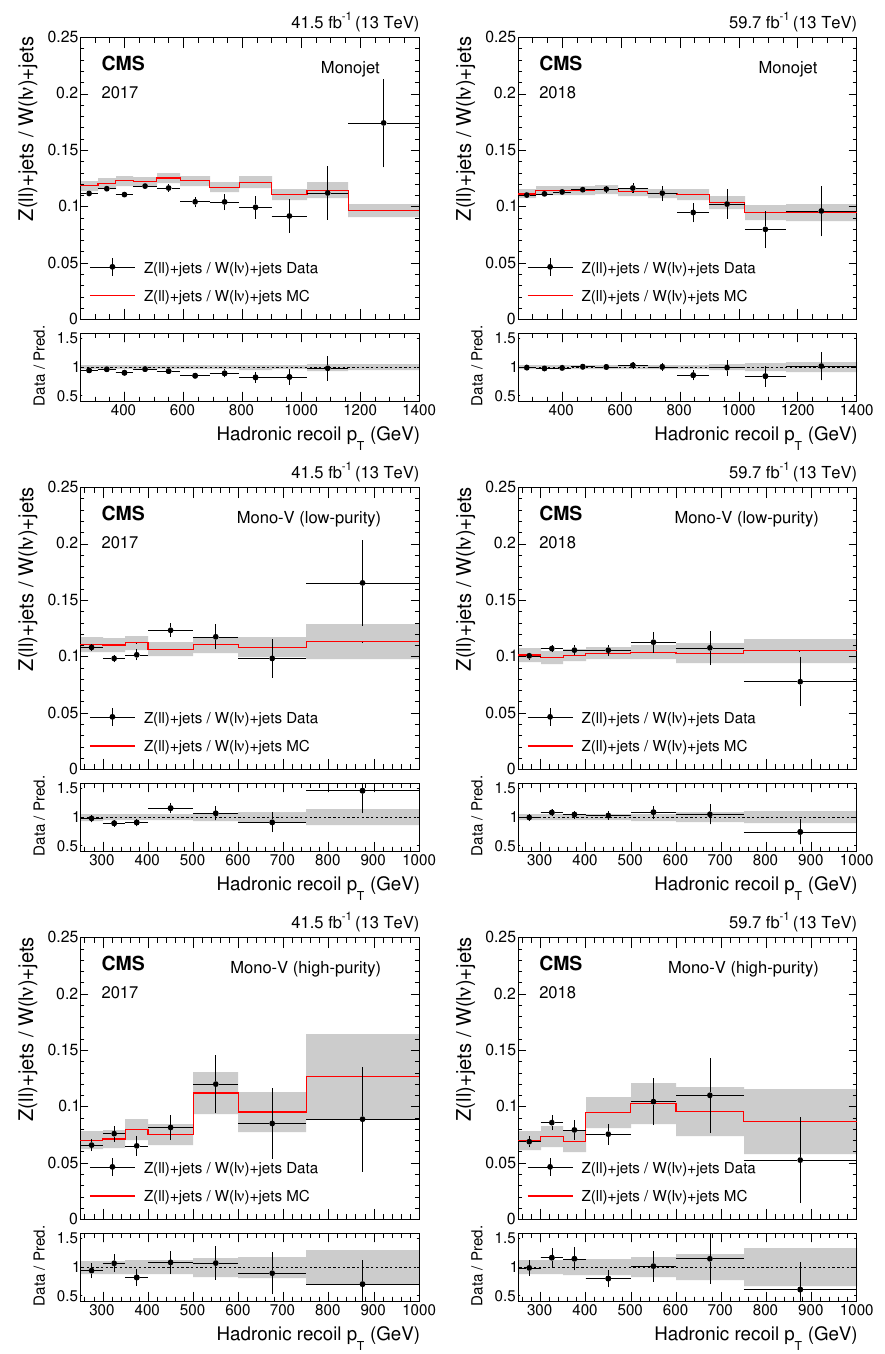
Figure 2 . Ratio of the dilepton to single-lepton control region yields predicted using simulation (red solid line), and observed in data (black points). The gray band represents the total uncertainty in the ratio. In the lower panels, the ratio of data over prediction is shown. From upper to lower, the rows show the monojet, low-purity, and high-purity mono-V categories, while the left (right) column represents the 2017 (2018) data